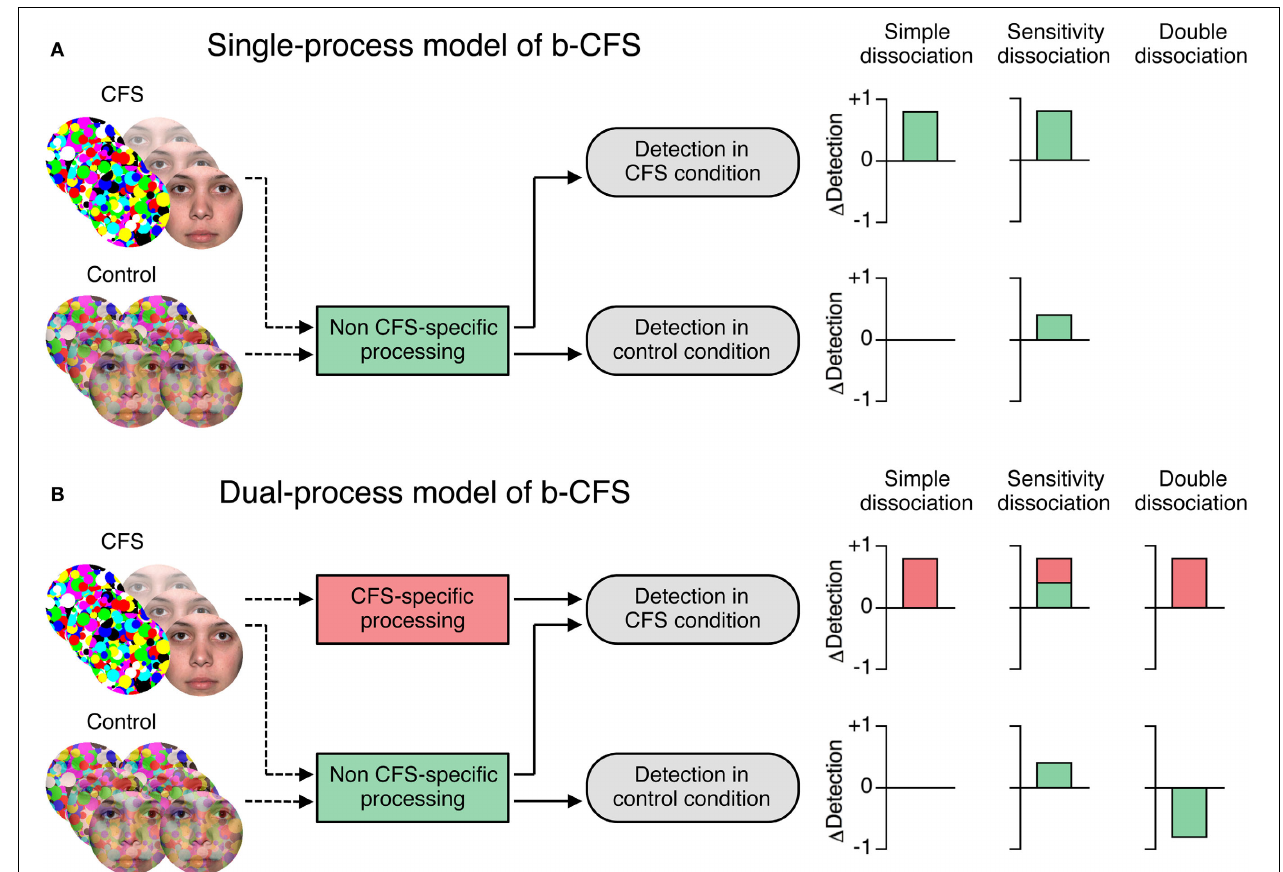
FIGURE 1 | Competing models of the processes mediating detection performance in the b-CFS paradigm. (A) The single-process model posits that both the CFS and the control condition measure differences between stimuli in accessing awareness that exist independent of the application of CFS, i.e., that are caused by non CFS-specific processing differences (green boxes and bars). The bar graphs on the right show how the single-process model would account for hypothetical detection differences ( (cid:2) Detection in arbitrary units) between two stimuli in the CFS condition (top) and in the control condition (bottom). To account for simple and sensitivity dissociations, the single-process model would need to assume that the CFS condition represents a more sensitive measure of non CFS-specific processing differences than the control condition. The single-process model cannot account for double